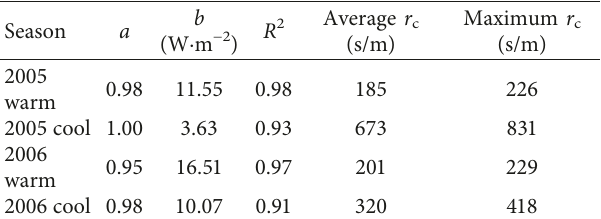
aX + b ; Y is measured LE; X is predicted m − 2 ). Y (cid:29) ·